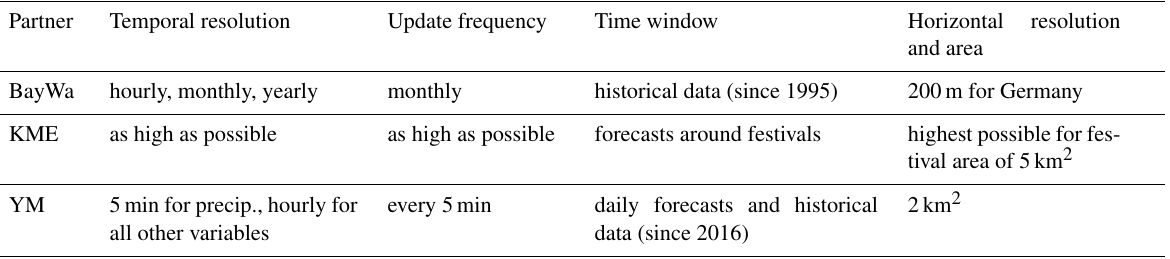
Table 2. Requirements for the meteorological information with respect to temporal resolution, update frequency, time window, and horizontal resolution.